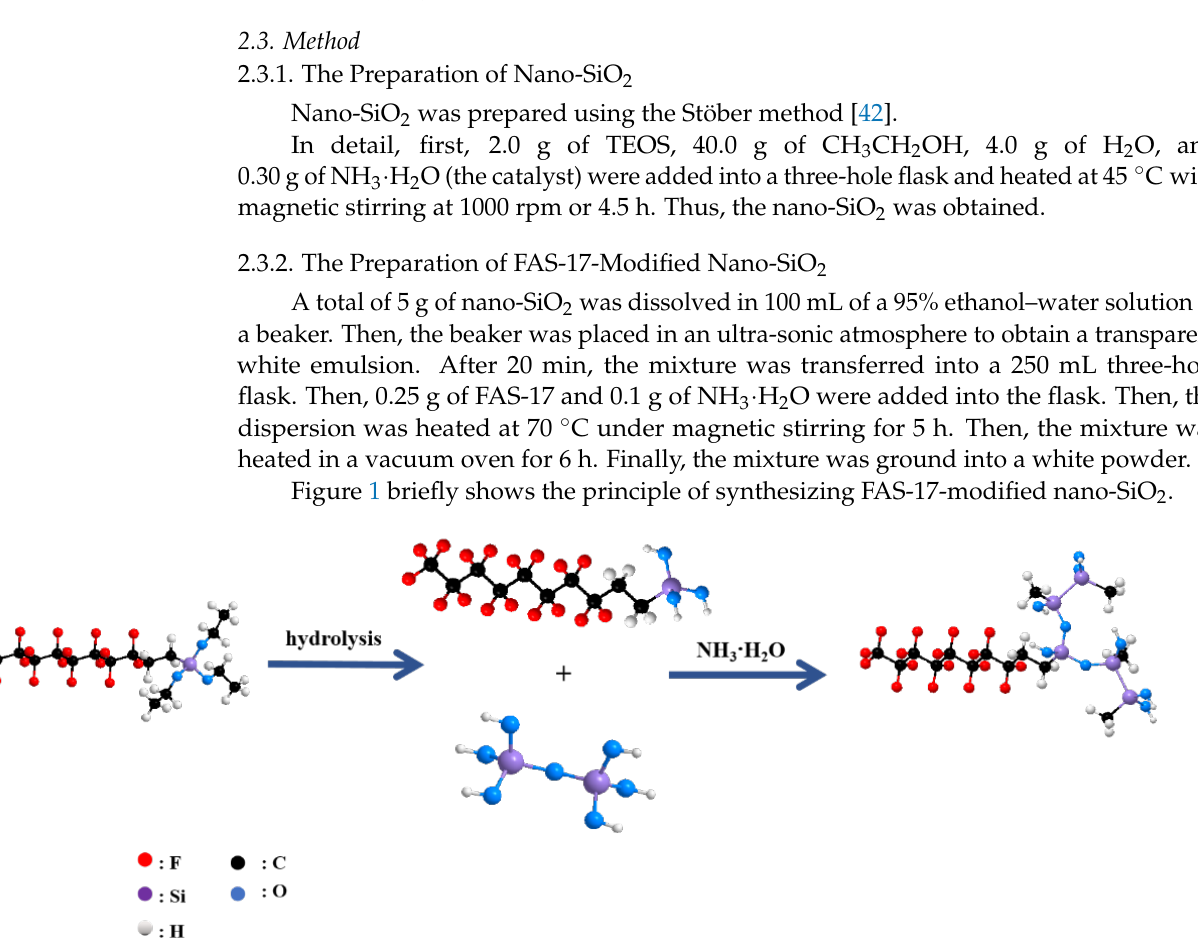
Figure 1. Schematic diagram of the construction of a porous FAS-17-modified SiO 2